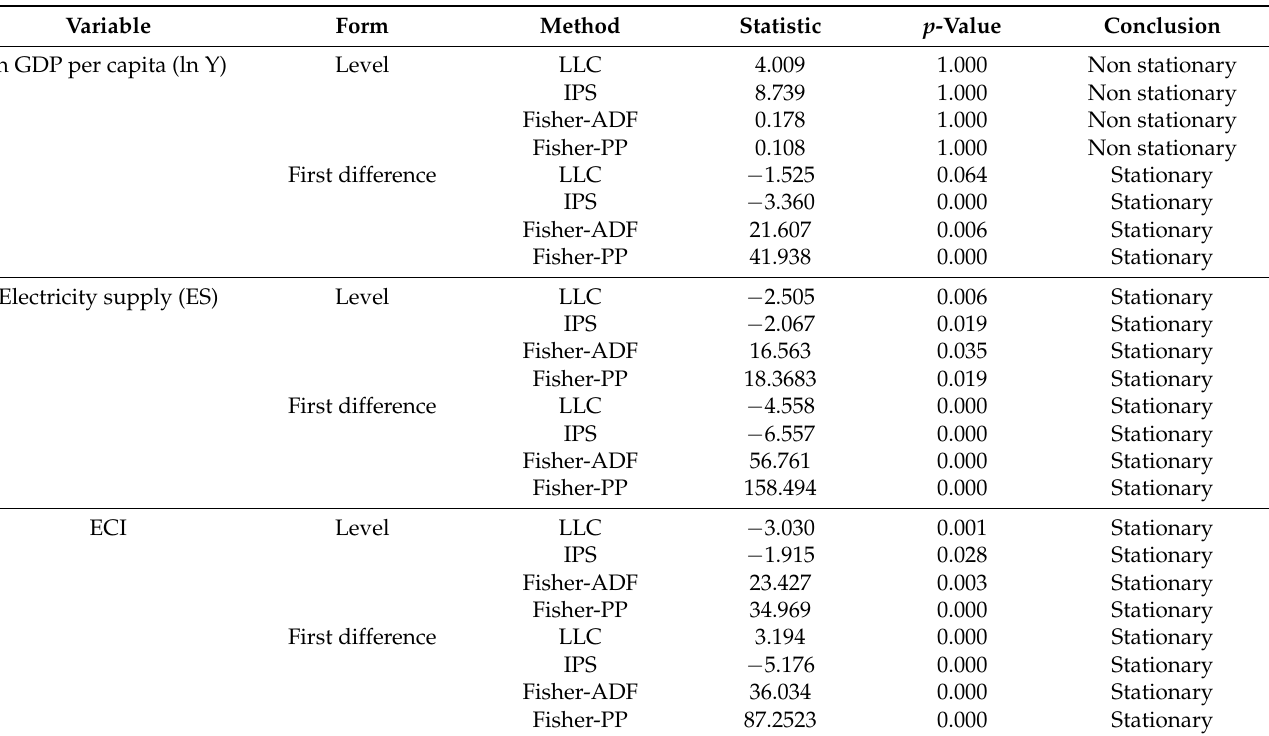
Table 3. Panel unit root test